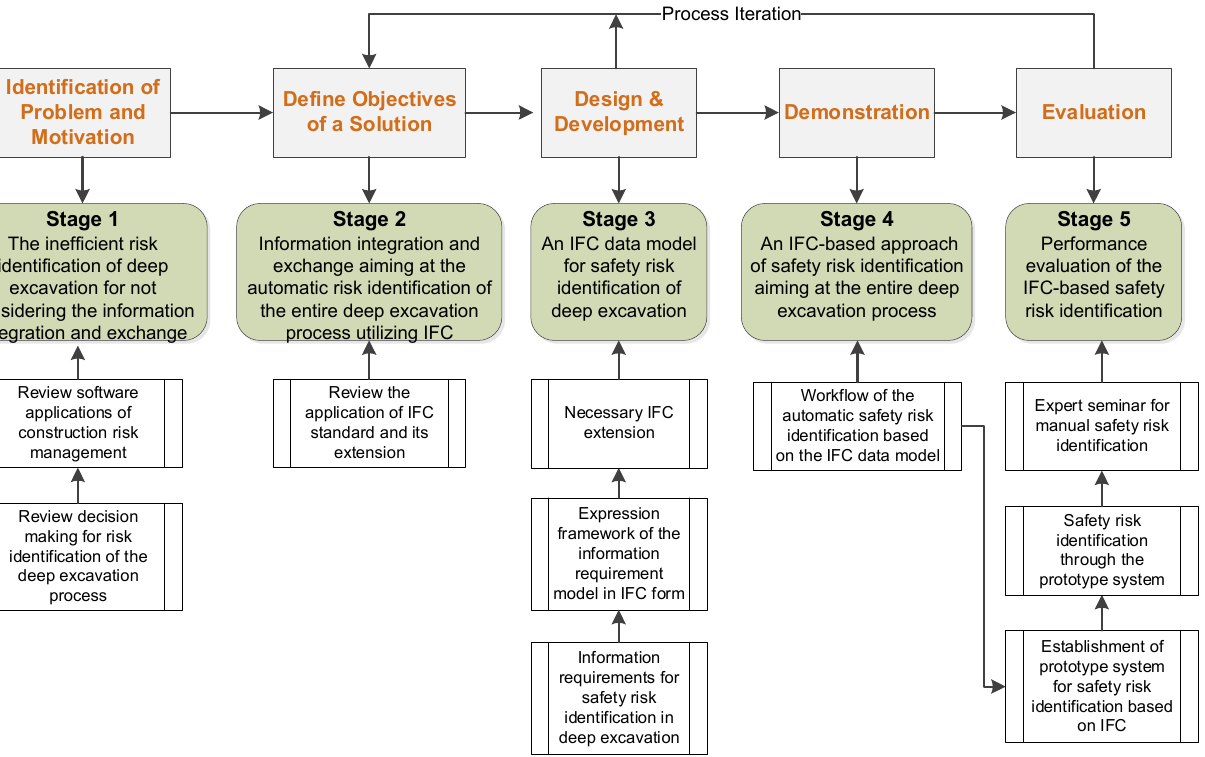
Figure 1. Research process undertaken based on the research